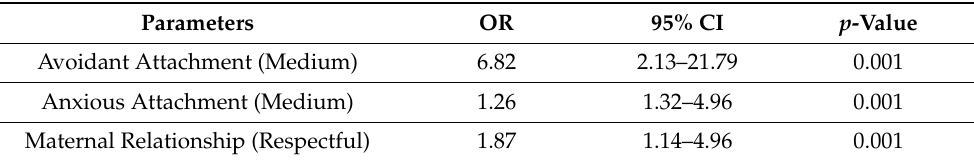
Table 3. Multiple binary logistic regression analysis of the parameters selected between aggressors with alexithymia and no